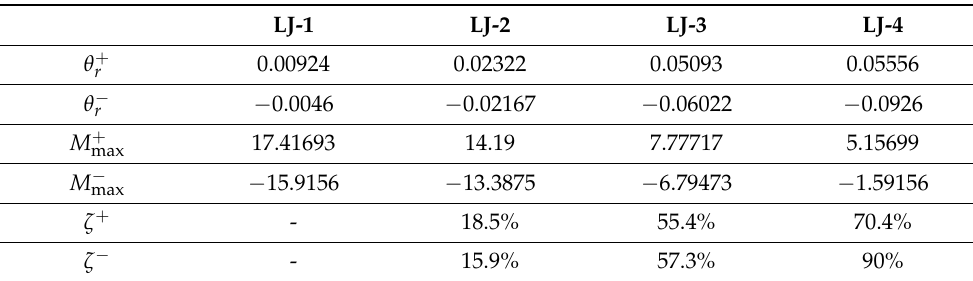
Table 2. The changing of initial rotation angles, the maximum restoring moment and the decline ratio of maximum restoring moment.